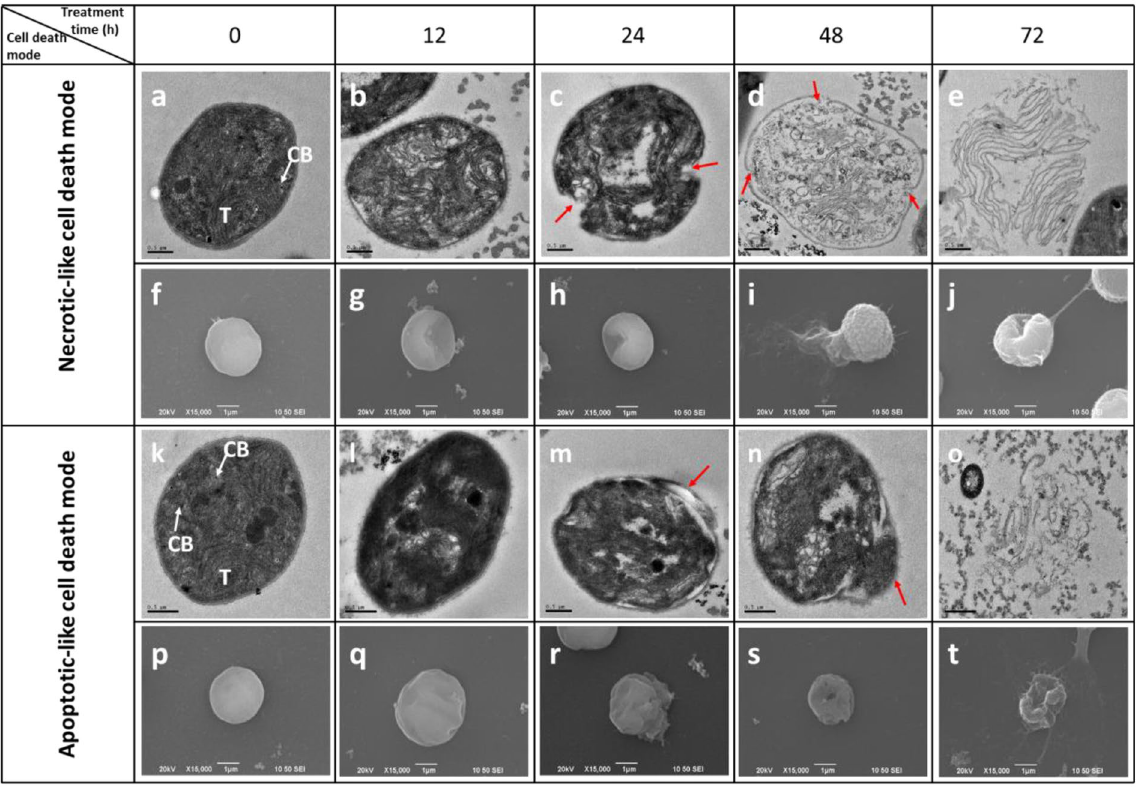
Figure 5. Two cell death modes in M. aeruginosa visualized by TEM and SEM. Damaged cells of M. aeruginosa treated with PG (30 µ g/mL) for 12, 24, 48 and 72 h. ( a , f , k and p ): control cell; ( b – e and g – j ): necrotic-like cell death mode; ( l – o and q – t ): apoptotic-like cell death mode. (T: thylakoids; CB: carboxysome). Red arrows show where the cell membrane was broken. TEM images: bars = 0.5 µ m; SEM images: bars = 1 µ